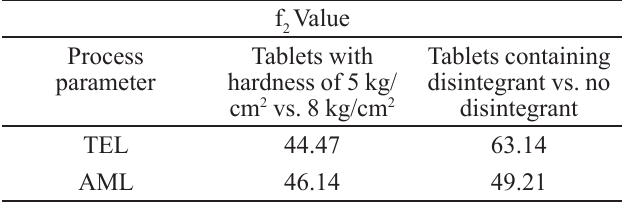
TABLE III - Similarity factor (f with different parameters